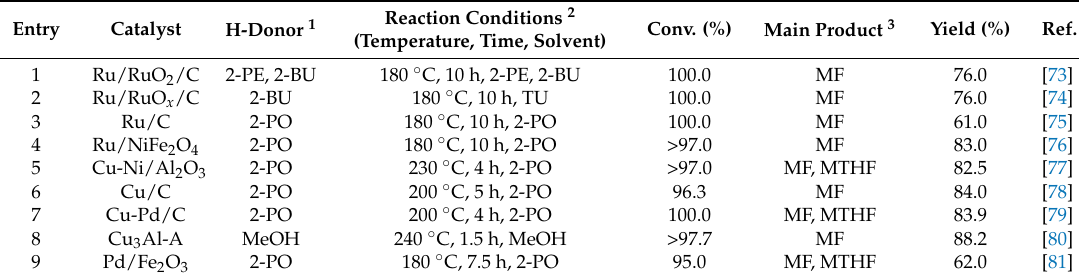
Table 4. A literature overview of the examples of metal catalysts used in CTH of